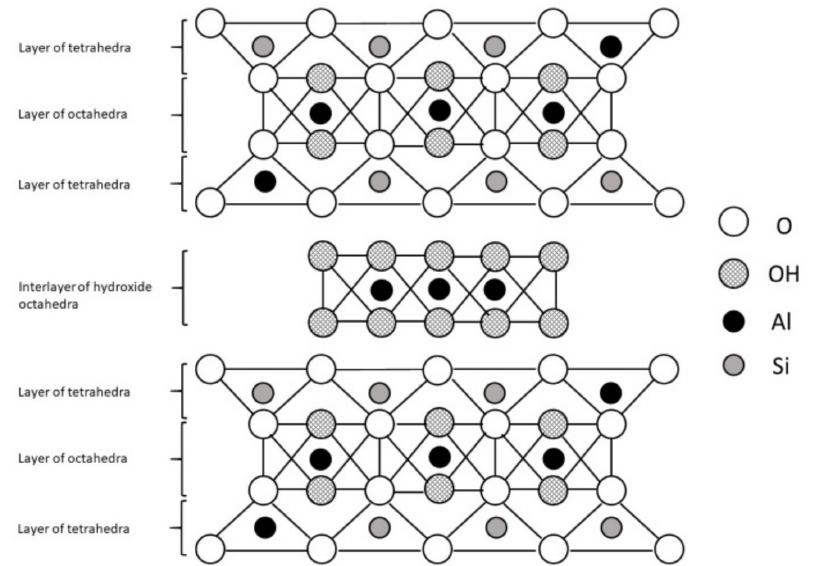
Figure 3. The 2:1:1 layer phyllosilicate